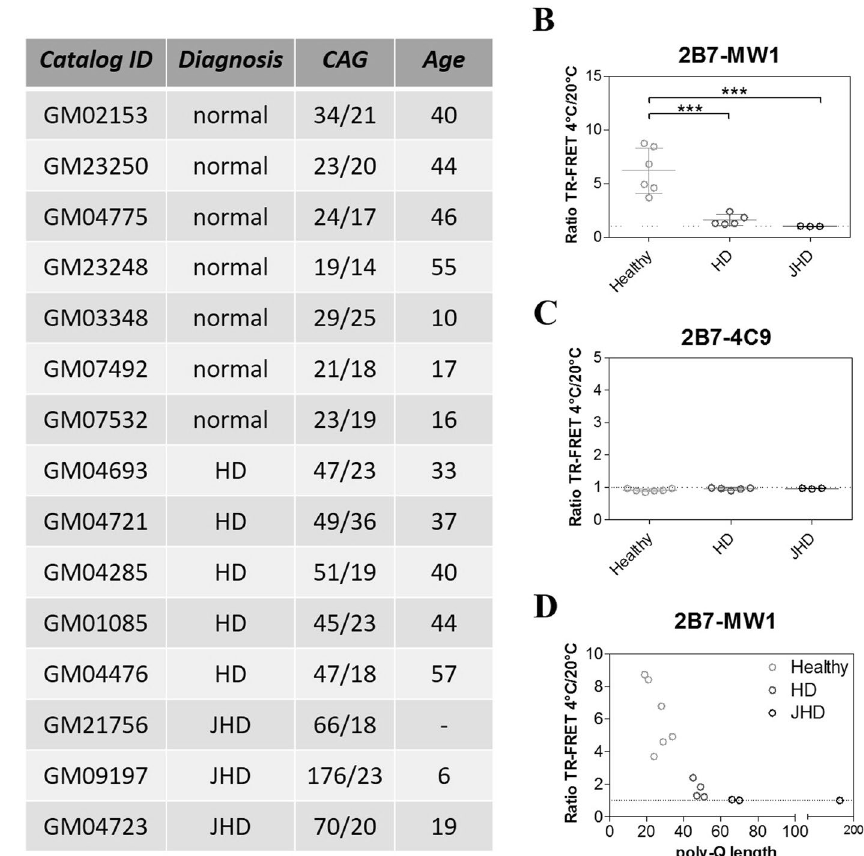
Figure 5. The 2B7/MW1 conformational immunoassay detects mHTT conformation in lysates of immortalized control and HD human fibroblasts (obtained from heterozygous HD donors). ( A) Table illustrating the salient features of human control and HD immortalized fibroblasts used in this study. ( B ) Summary of 2B7/MW1 conformational immunoassay data (ratio TR-FRET signals at 4 °C/20 °C) obtained on lysates of control and HD fibroblasts. ( C ) Summary of 2B7/4C9 control immunoassay data (ratio TR-FRET signals at 4 °C/20 °C) obtained on the same lysates of control and HD fibroblasts. ( D ) Same as A, plotted against CAG (polyQ) repeat length rather than against control/HD genotype. In B and C values represent means and standard deviations of the means of three independent experiments (two-way ANOVA with Bonferroni’s post-test, degrees of significance are